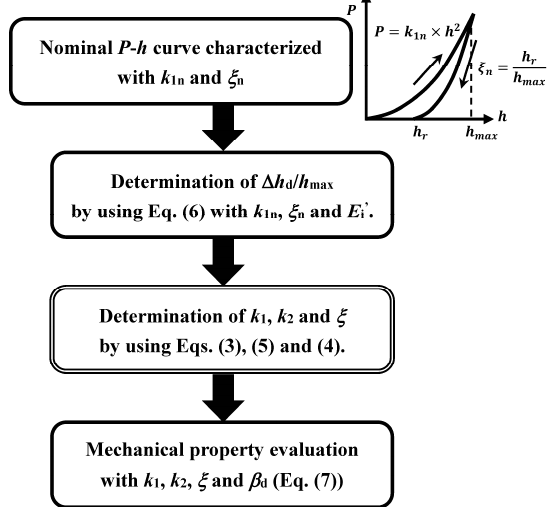
Figure 8. Indentation hardness H M estimated with simulated P - h curves plotted against H M evaluated with mechanical properties inputted into the FEM model and with simulated β d .